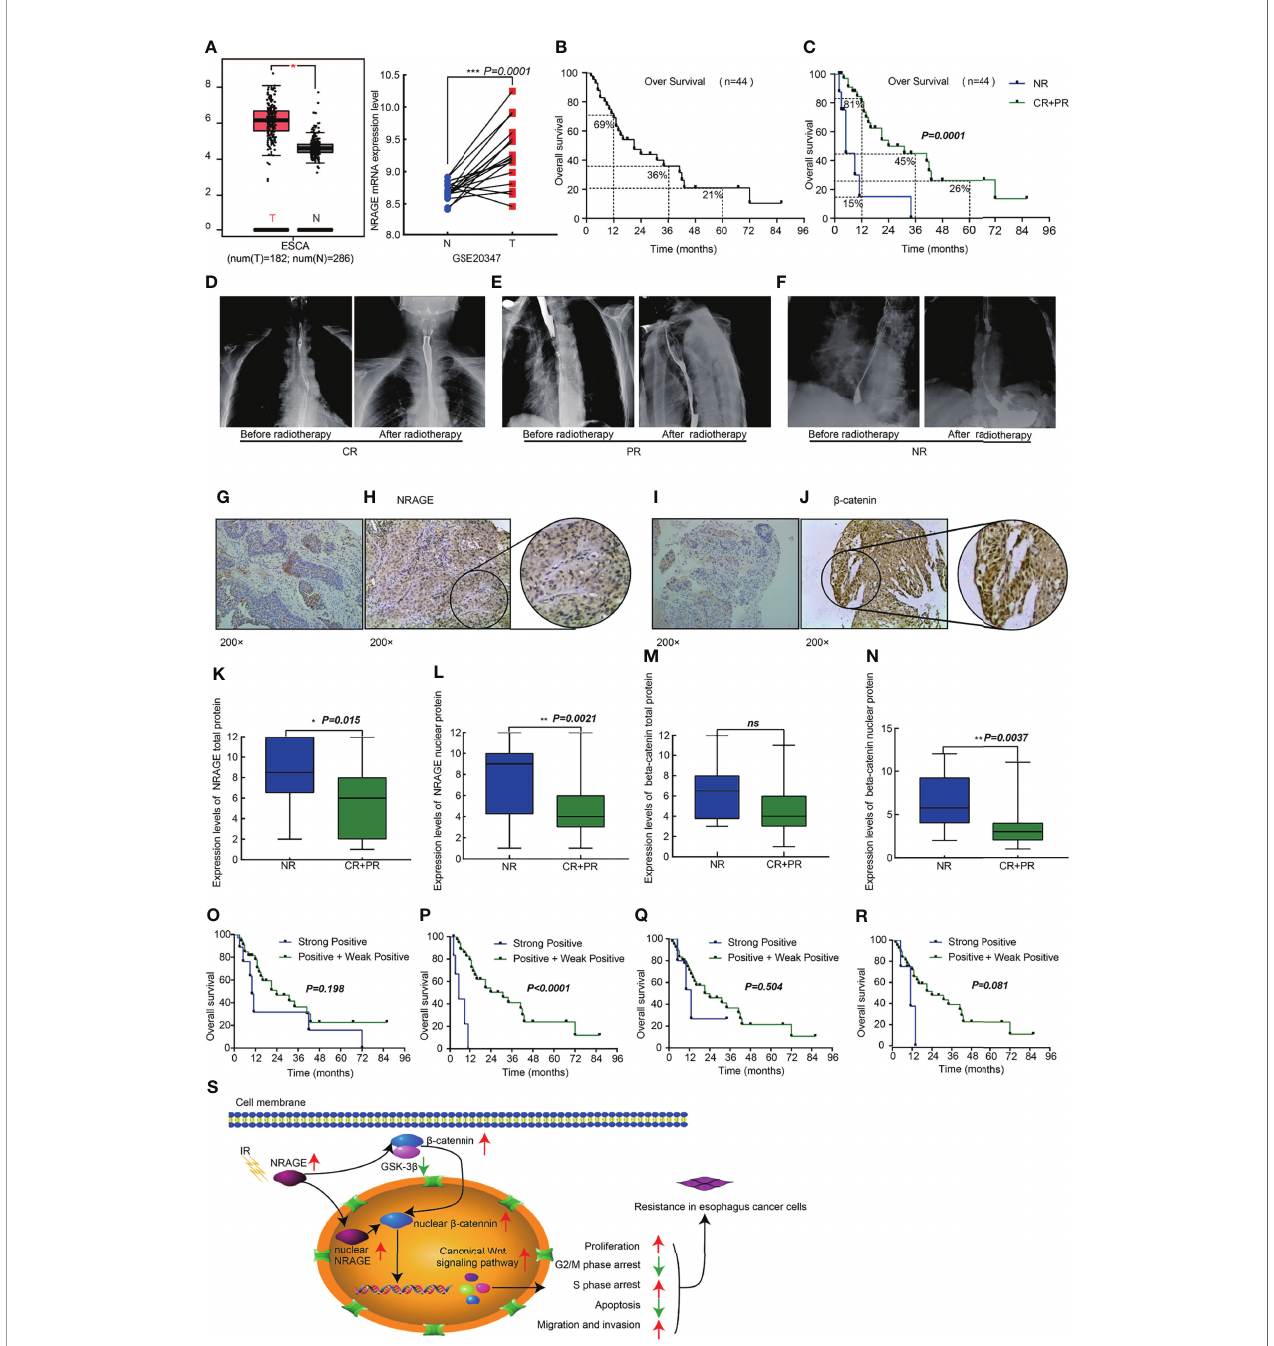
FIGURE 6 | High expression nuclear NRAGE in patient samples with ESCC following radical radiotherapy correlates with poor survival. (A) NRAGE Expression in esophageal cancer tissues and normal control esophageal tissues from the TCGA (left, ESCA) and the GSE20347 (Right, ESCC) data; (B) Kaplan – Meier overall survival curves for all 44 patients with esophagus cancer; (C) Kaplan – Meier overall survival curves for all 44 patients with esophagus cancer strati fi ed by NR and CR + PR; (D – F) Images of radiotherapeutic short-term effects, CR (D) , PR (E) , NR (F) ; (G, H) Representative images of NRAGE negative (G) and positive (H) expression; (I, J) Representative images of b -catenin negative (I) and positive (J) expression; (K, L) Comparison of NRAGE total (K) and nuclear (L) protein expression between NR group and CR + PR group; (M, N) Comparison of b -catenin total (M) and nuclear (N) protein expression between NR group and CR + PR group; (O, P) Kaplan – Meier overall survival curves for all 44 patients with esophagus cancer strati fi ed by strong positive and weak positive+positive expression of NRAGE total (O) and nuclear (P) protein; (Q, R) Kaplan – Meier overall survival curves for all 44 patients with esophagus cancer strati fi ed by strong positive and weak positive + positive expression of b -catenin total (Q) and nuclear (R) protein; (S) Schematic illustration depicting the NRAGE associations with cancer proliferation, apoptosis, cell cycle and invasive migration that induce resistance to radiation. * p < 0.05; ** p < 0.01; *** p < 0.001; ns, no signi fi